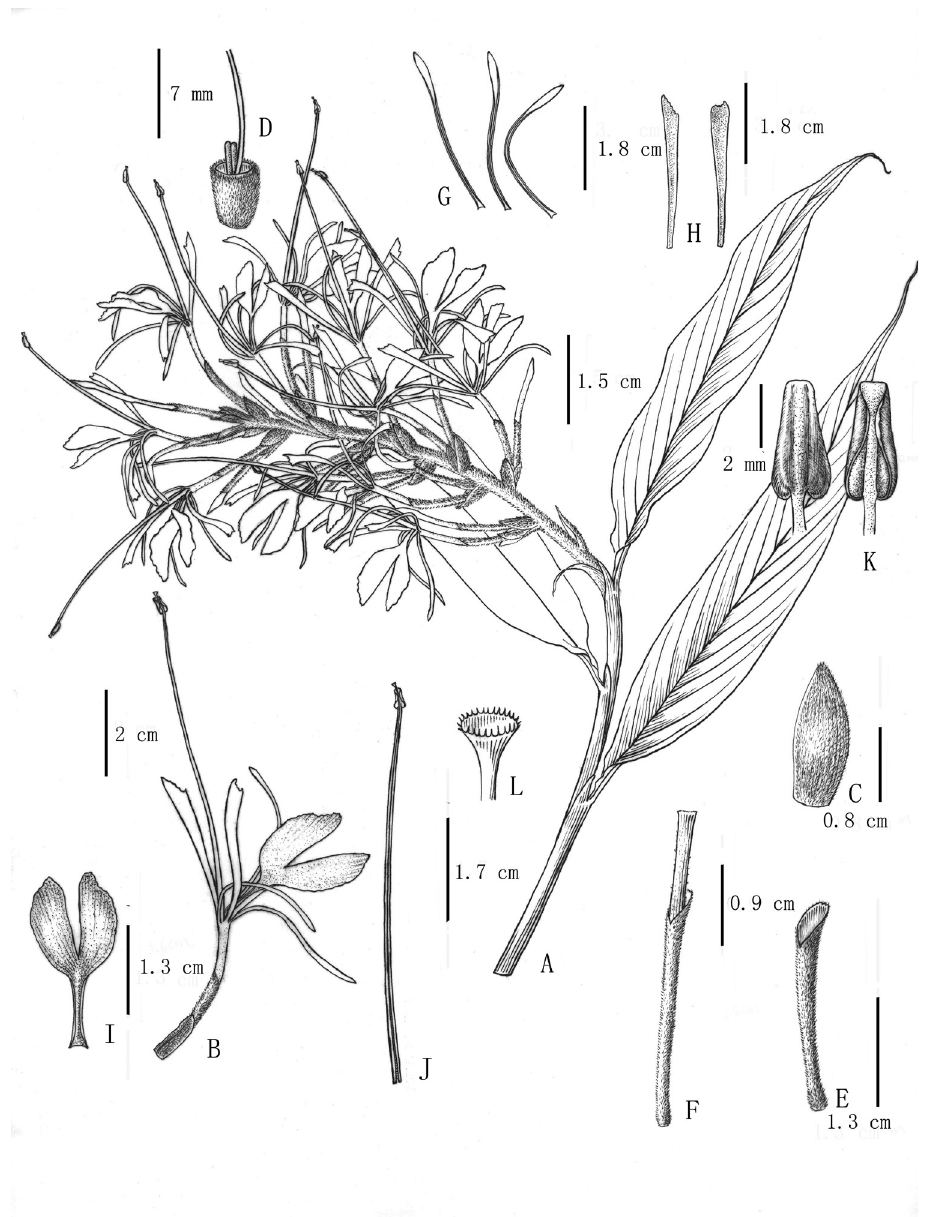
Figure 1. Hedychium viridibracteatum X.Hu, sp. nov., holotype, A upper leaves and inflorescence B flow- er C bract D ovary and glands E calyx tube F floral tube with calyx tube wrapped outside G corolla lobe H lateral staminodes I labellum J stamen K anther L stigma. Drawings Y. X. Liu. tubular, apex acute, green, coriaceous1.0–1.1 × 0.3–0.4 cm, pubescent outside, gla- brous inside. Flowers pure white, 10–11 cm long, lightly fragrant. Calyx tubular, green, 2.5–2.8 × 0.12–0.15 cm, apex obtusely 3-toothed, pubescent. Floral tube pure